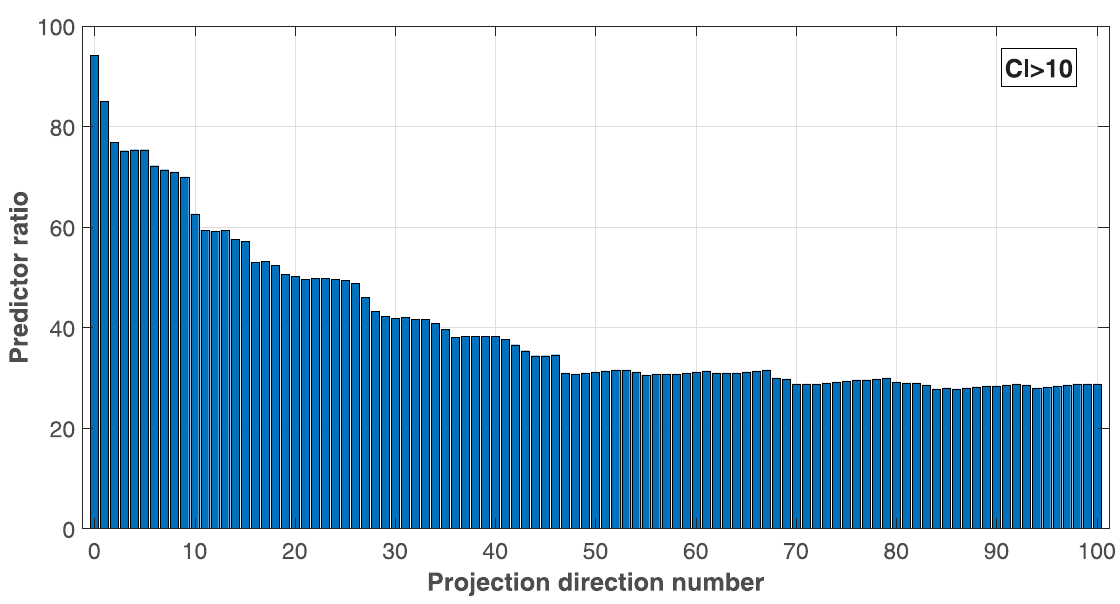
Fig 8. Predictor ratios at CI > 10 over the projection direction